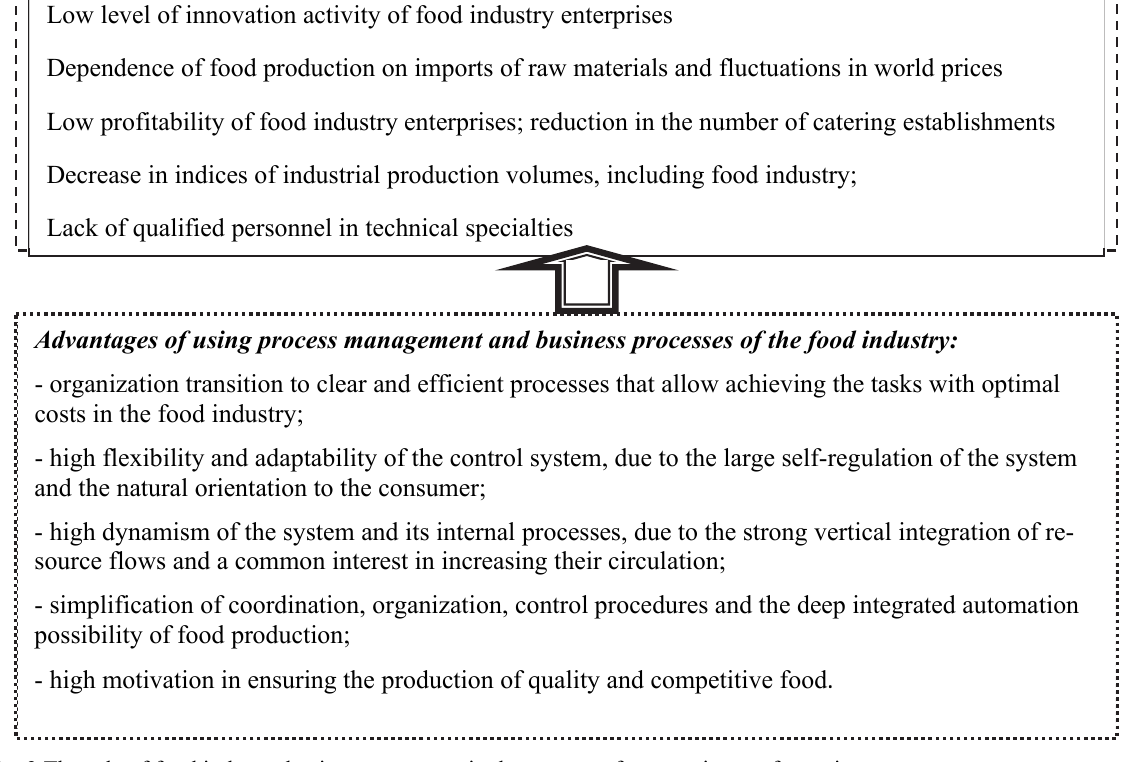
Fig. 3 The role of food industry business processes in the context of economic transformations Source: developed by